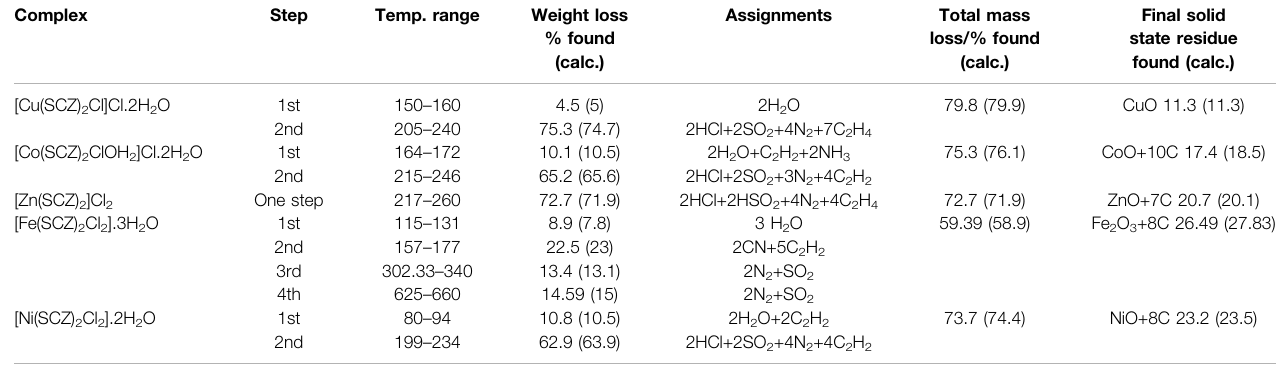
Assignments Total mass % found (calc.)